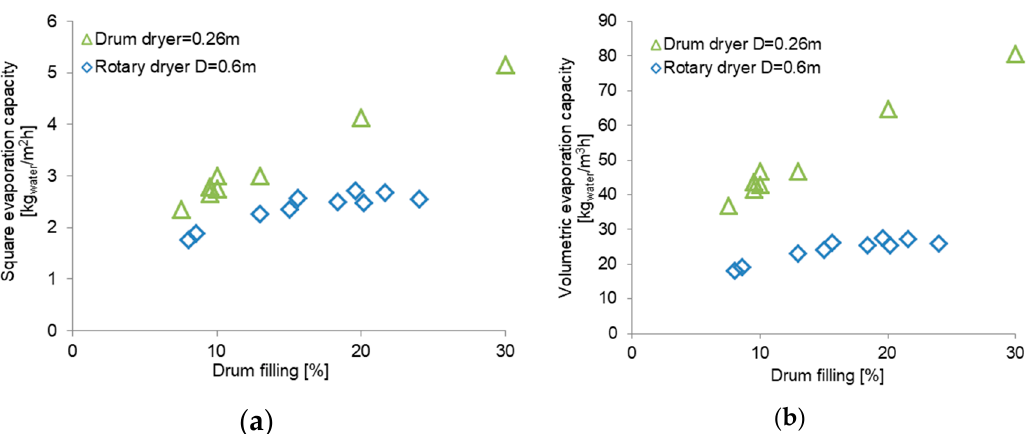
Figure 8. ( a ) Square evaporation capacity; ( b ) Volumetric evaporation capacity for drying between 50 Figure 8. (a) Square evaporation capacity; (b) Volumetric evaporation capacity for drying between 50 and 30 wt % and a heating temperature of 135 ◦ C. and 30 wt % and a heating temperature of 135 °C.